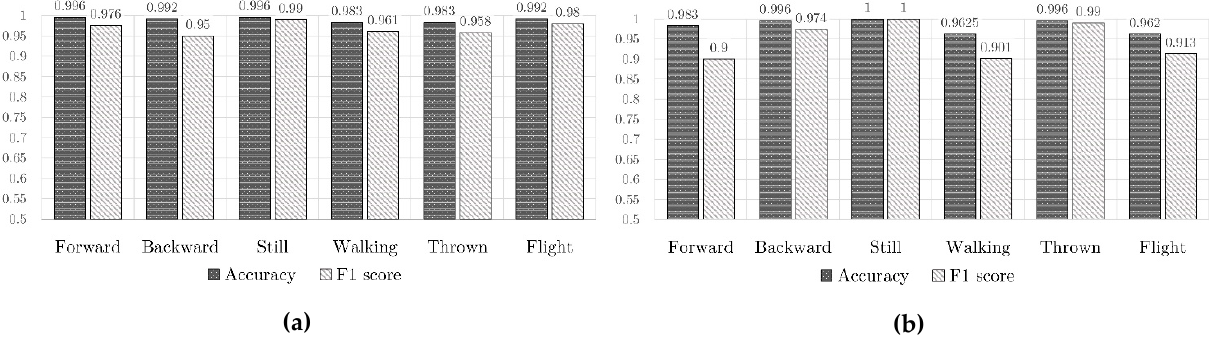
Figure 9. Accuracy and F1 score for ( a ) TDNN ( b ) RNN.